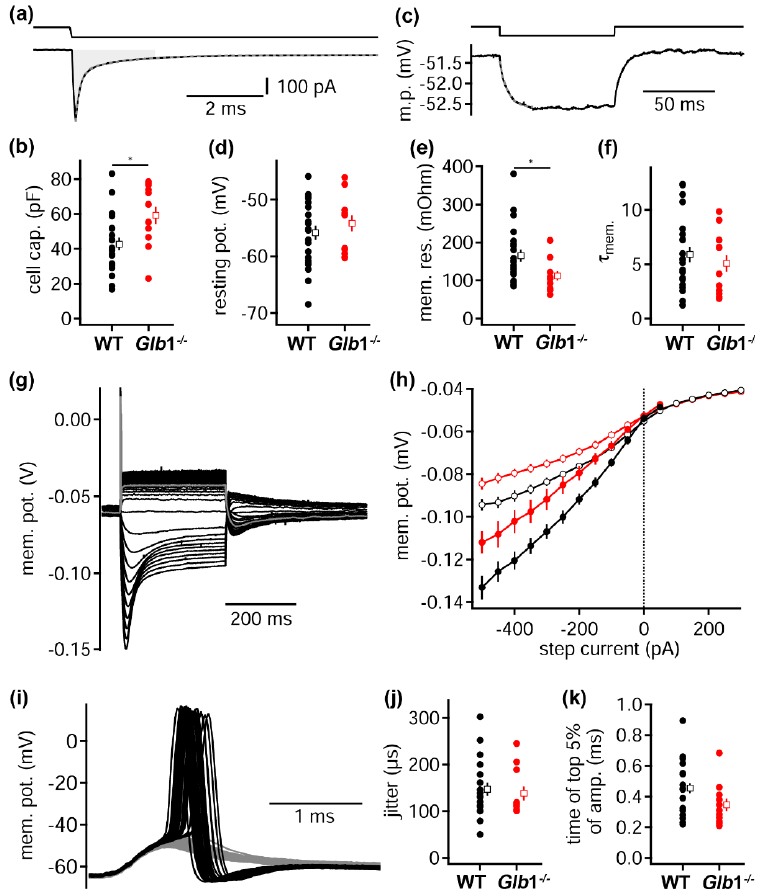
Figure 7. Electrophysiological characterization of G M1 -gangliosidosis-associated lesions. Sub- and supra-threshold properties of 3.5 to five-month-old Glb1 − / − and WT neurons of the medial nucleus of the trapezoid body. ( a ) Voltage steps from − 60 to − 65 mV (top) induce a charging transient (bottom) used to calculate the cell capacitance ( b ). The gray shaded area indicates the region of the charge transfer (tau weighted × 5) that was used to calculate the membrane capacitance. The gray dotted line represents the bi-exponential fit to the average trace. * p = 0.0147 ( b ) Cell capacitance of WT and Glb1 − / − MNTB neurons. Round symbols represent single cells, and open squares the average (mean ± sem). ( c ) Current injections of − 10 pA (top) induce a small hyperpolarization (bottom) used to extract the membrane resistance ( e ) and the time constant ( f ). Trace represents the average of 100 repetitions; the gray dotted line is an exponential fit from start to the maximal deflection. ( d ) Resting membrane potential of WT and Glb1 − / − MNTB neurons. ( e ) Membrane resistance of WT and Glb1 − / − MNTB neurons. Symbols as in ( b ), * p = 0.0128. ( f ) Membrane time constant ( τ mem ) of WT and Glb1 − / − MNTB neurons. Symbols as in ( b ). ( g ) Sub- and supra-threshold voltage response to current injections. Gray trace represents first supra-threshold current injection. ( h ) Sub-threshold input–output function of WT (black) and Glb1 − / − (red) MNTB neurons extracted from voltage response shown in ( g ). Closed symbols depict the maximal voltage deflection; open symbols the voltage response of the steady state level at the end of the current injection. ( i ) Threshold current injection trigger supra- (black) and sub- (gray) threshold voltage responses. ( j ) Action potential jitter, defined as the standard deviation of the peak time of supra-threshold events of experiments as shown in ( i ). Symbols as in ( b ). ( k ) Time the sub-threshold events stay above the top 5% of the voltage amplitude. Symbols as in ( b